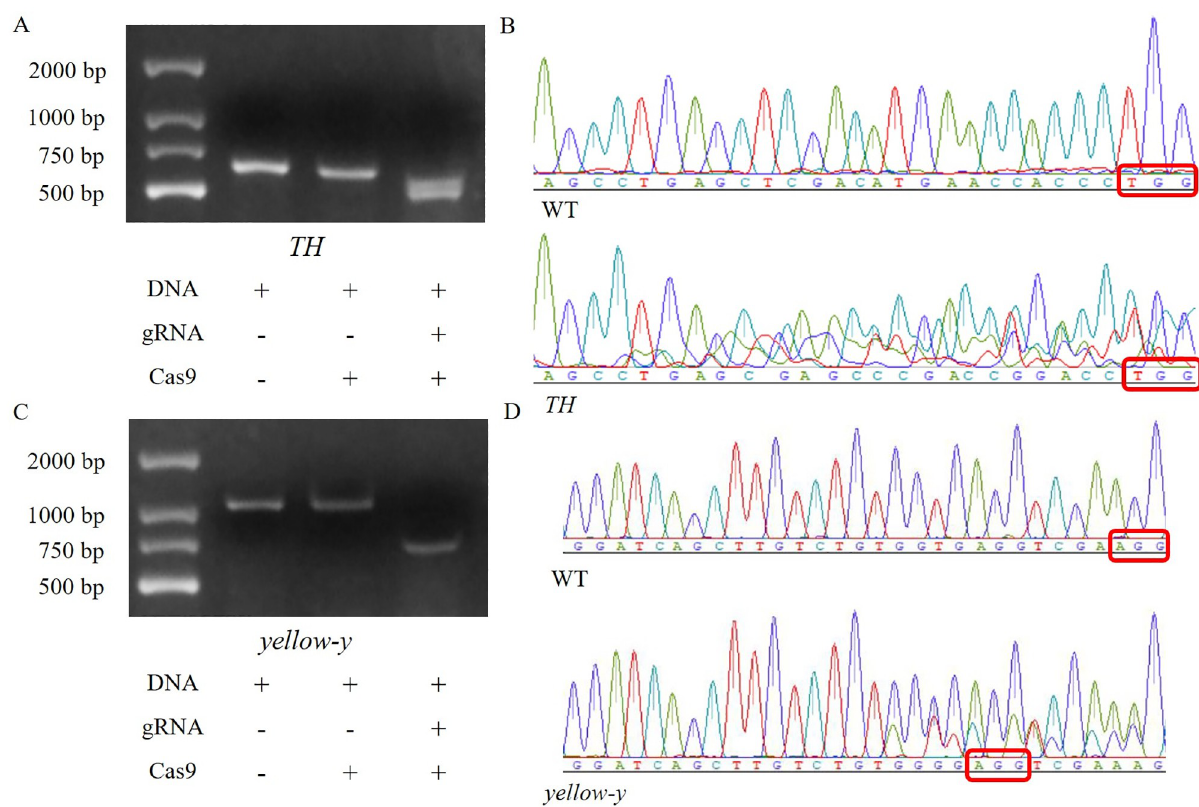
Fig 2. Verification of the effectiveness of the target. (A) In vitro verification of TH sgRNA. (B) DNA sequencing results of WT eggs and eggs injected with TH sgRNA and Cas9 protein. (C) In vitro verification of yellow-y sgRNA. (D) DNA sequencing results of WT eggs and eggs injected with yellow-y sgRNA and Cas9 protein. The red box refers to the PAM